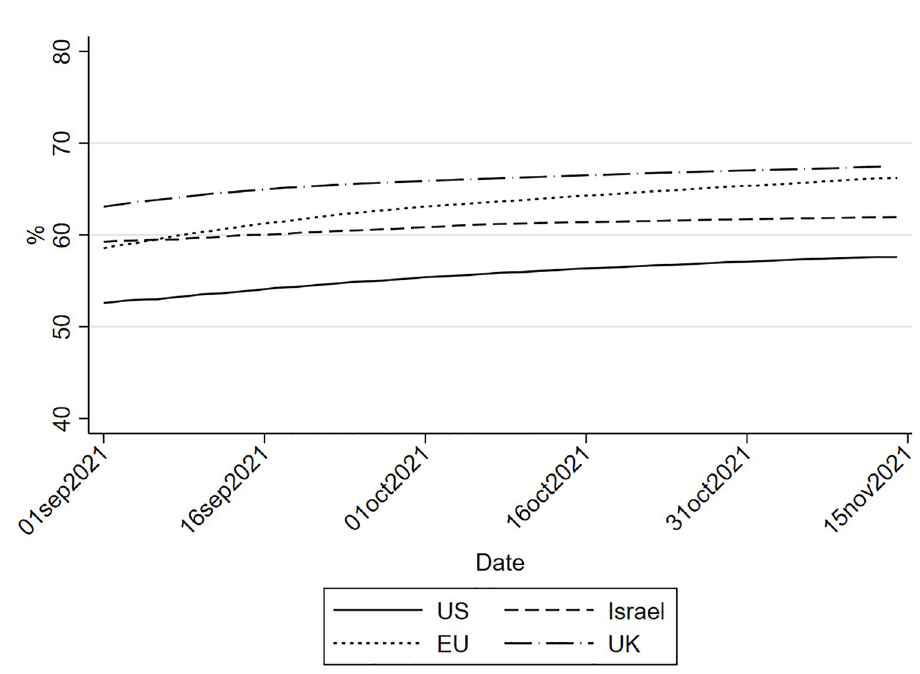
Fig 5. Evolution of the vaccination rates (full vaccinations) in the EU, the UK, Israel and the US. Notes : Source: